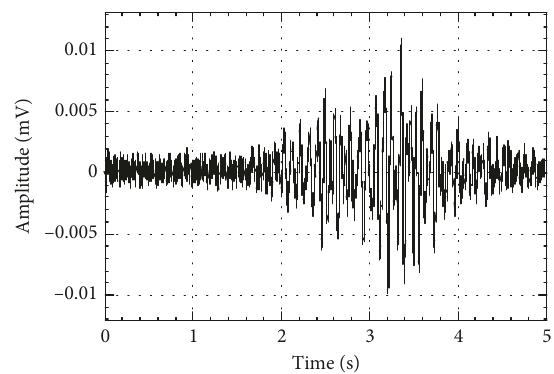
Figure 8: Original microseismic